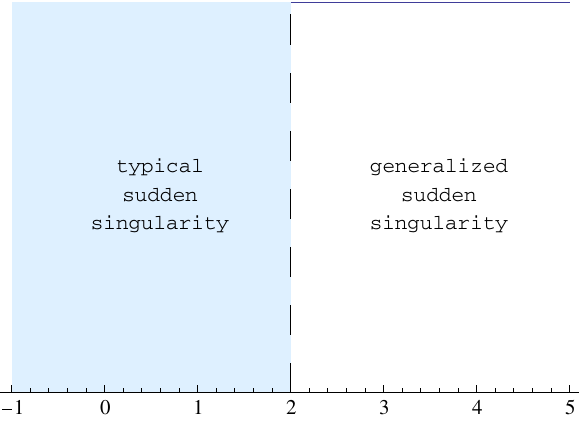
Fig. 7 Thediagrampresentsthegenerictypesofsingularityinthepole inflation model with respect to the value of the parameter n